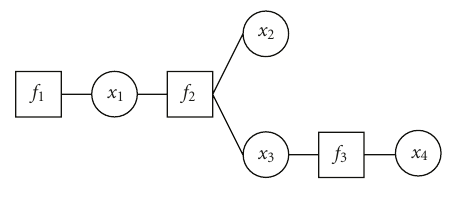
Figure 3: Example for a factor